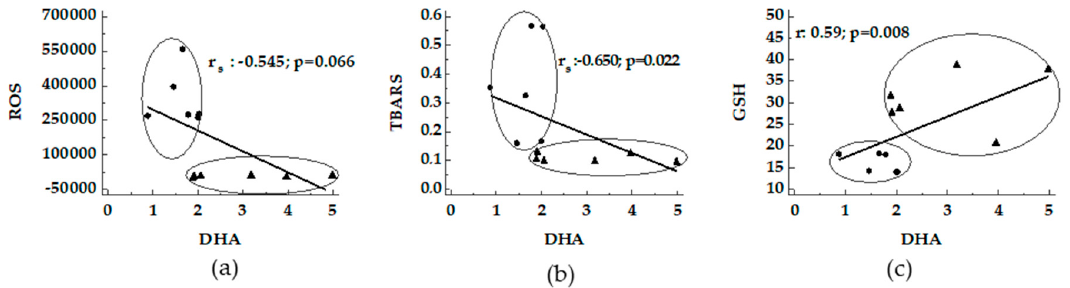
Figure 3. Correlation between DHA and oxidative stress in livers from MCD and Obese Zucker rats. The association between DHA versus ROS (panel a ), TBARS (panel b ) and GSH (panel c ) were reported. • : MCD rats; (cid:78) : Obese Zucker rats. 3.3. Correlation between Desaturase Activity Indexes and DHA Versus Matrix Metalloproteinases A positive correlation between D5D and D9-16D and D9-18D versus activity and protein expression of MMP-2 was found in livers from MCD and Obese Zucker rats (Figures 4 and 5). In MCD rats a good correlation between D9-18D versus protein content of MMP-9 was detected (r s 0.99, p <